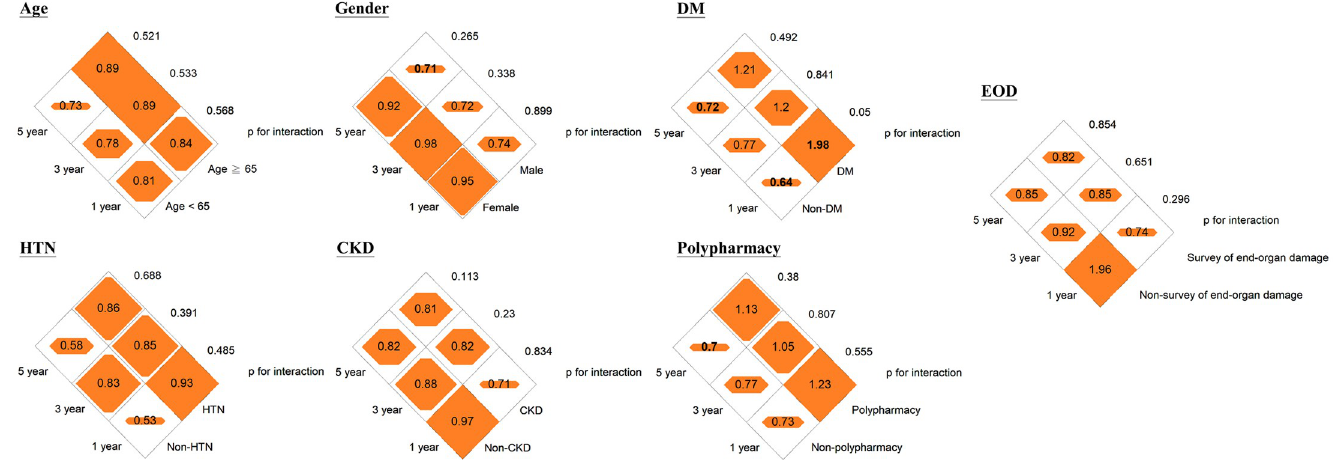
Fig 4. Diamond graphs summarize the adjusted hazard ratios (HRs) of 7-day, 30-day, and 60-day incident stroke by clinical characteristics of the study population. DM, diabetes; HTN, hypertension; CKD, chronic kidney disease; EOD, end-organ damage. Numbers in the orange diamonds stand for the adjusted HRs, where the bold numbers represent the 95% confidence interval not overlapping with null value 1.0. Detailed information is provided in the S3C Table.